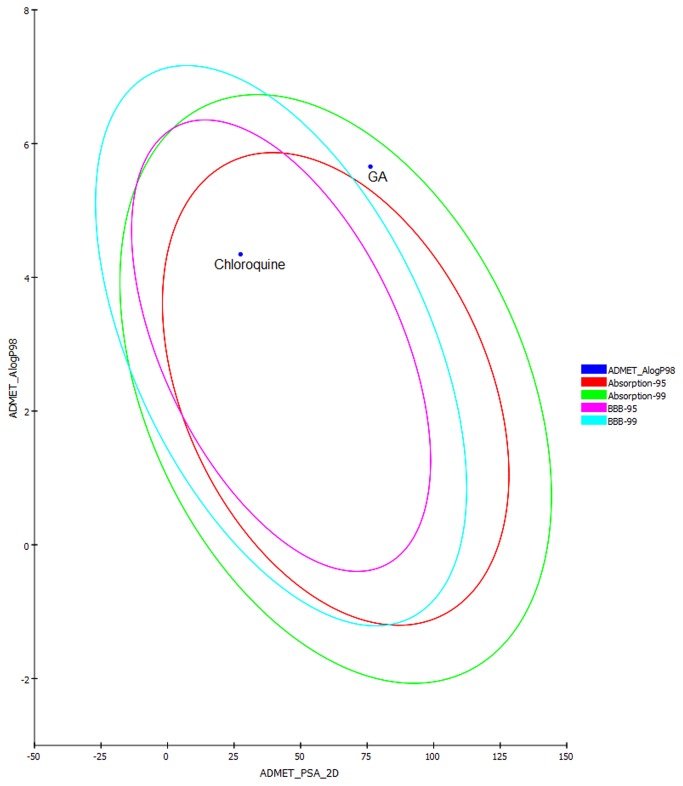
Adsorption model of the candidate compounds.